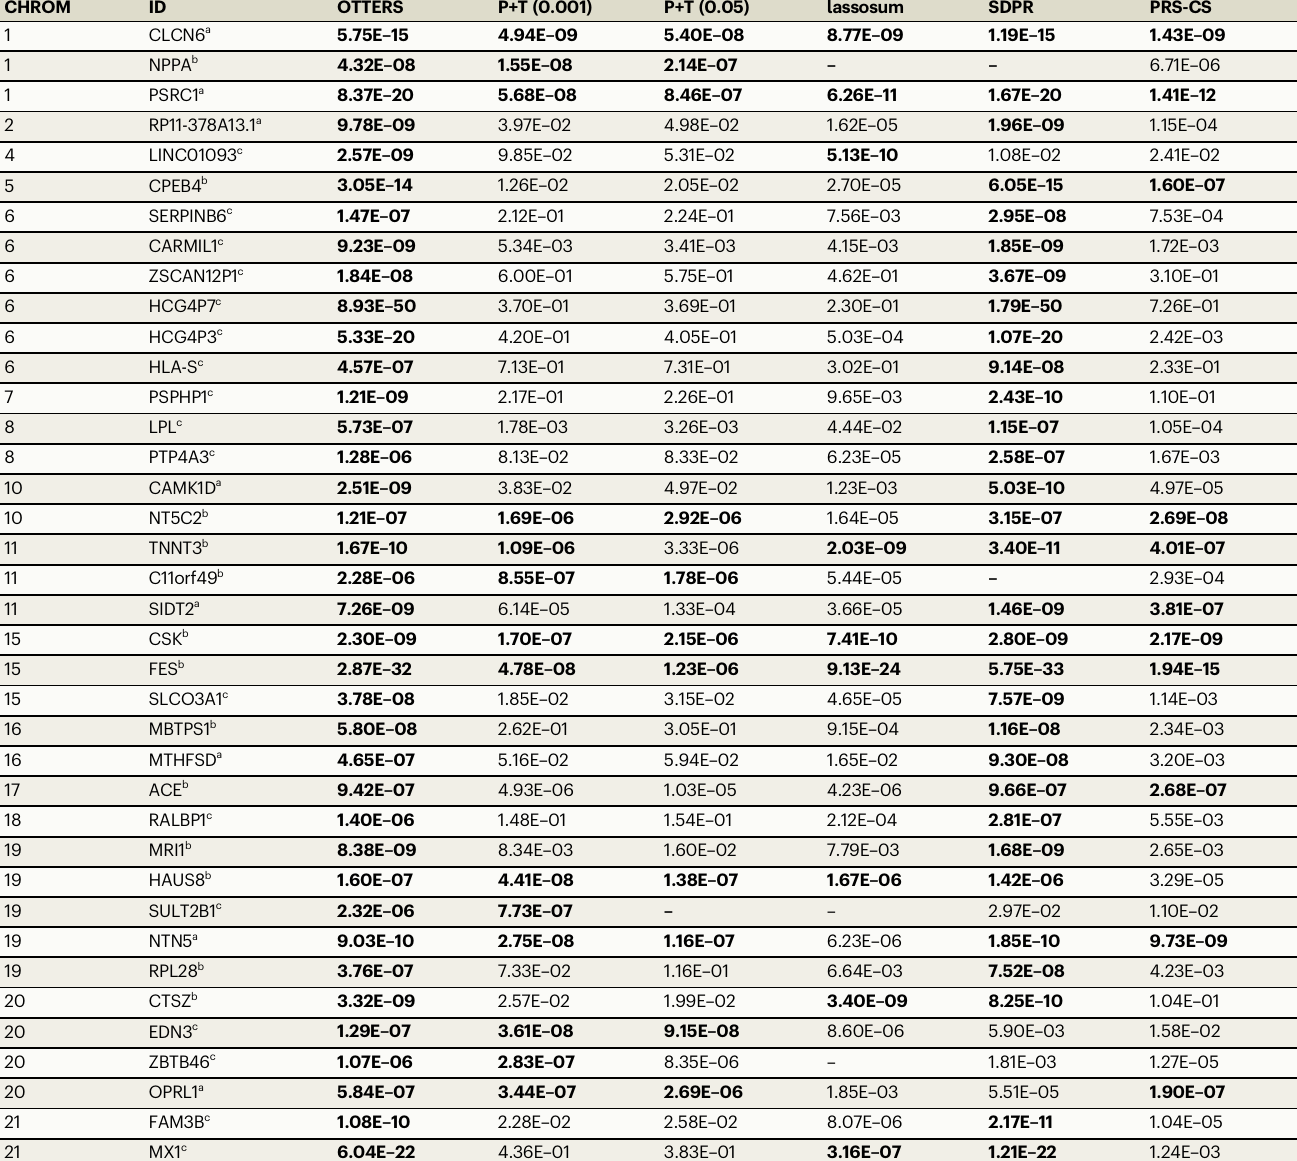
Table 2 | Independent TWAS risk genes of cardiovascular disease identi fi ed by OTTERS CHROM ID OTTERS P+T